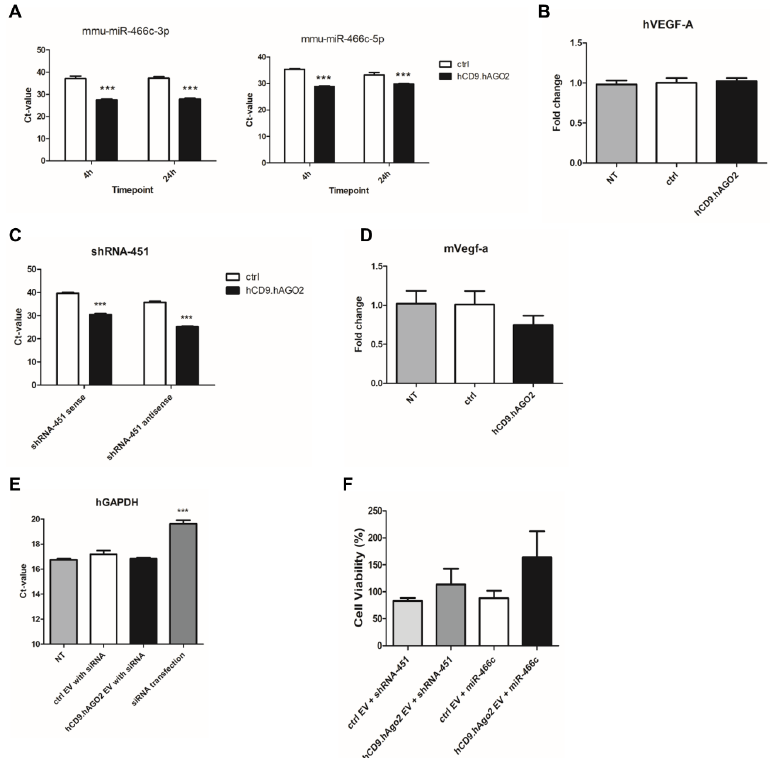
Figure 3. Delivery of RNA to recipient cells using hCD9.hAGO2-engineered EVs. ( A ) hCD9.hAGO2 EVs loaded with miR-466c were shown to deliver the miRNA cargo to recipient ARPE19 cell line more efficiently than control EVs (with endogenous miR-466c loading). The uptake was observed already at 4 h timepoint and also observed still at 24 h timepoint. Data are presented as mean ± SD, n = 4. Two-tailed Student’s t -test: miR-466c-3p 4 h ctrl vs. hCD9.hAGO2 p -value < 0.0001; miR-466c-3p 24 h ctrl vs. hCD9.hAGO2 p -value < 0.0001; miR-466c-5p 4 h ctrl vs. hCD9.hAGO2 p -value < 0.0001; miR-466c-5p 24 h ctrl vs. hCD9.hAGO2 p -value 0.0004; ( B ) No effect on VEGFA expression was observed in ARPE19 cells after EV-mediated delivery of miR-466c. Data are presented as mean ± SD, n = 3; ( C ) Transfer of shRNA-451 from the EVs to recipient C166 cell line was observed by qRT-PCR. The fusion protein-enhanced loading to hCD9.hAGO2 EVs increased the shRNA-451 amount taken up in the cells. Data are presented as mean ± SD, n = 3. Two-tailed Student’s t -test: shRNA-451 sense ctrl vs. hCD9.hAGO2 p -value < 0.0001; shRNA-451 antisense ctrl vs. hCD9.hAGO2 p -value < 0.0001; ( D ) No effect on Vegfa expression was observed in C166 cells after the EV treatments (timepoint 7 d). Data are presented as mean ± SD, n = 3; ( E ) siRNA against GAPDH mRNA was loaded to EVs (hCD9.hAGO2 enhanced loading or endogenous loading as a control). ARPE19 cells were treated with the EVs but no change at GAPDH expression levels was observed. As a positive control, we used normal liposomal transfection reagent to deliver the siRNA and observed clear decrease in GAPDH mRNA levels as expected. Data are presented as mean ± SD, n = 3. Two-tailed Student’s t -test: NT vs. siRNA transfection p -value < 0.0001; ( F ) siRNA against GAPDH mRNA was loaded to EVs (hCD9.hAGO2 enhanced loading or endogenous loading as a control). ARPE19 cells were treated with the EVs but no change at GAPDH expression levels were observed. As a positive control, we used normal liposomal transfection reagent to deliver the siRNA and observed clear decrease in GAPDH mRNA levels as expected. Data are presented as mean ± SD, n = 3. Two-tailed Student’s t -test: NT vs. siRNA transfection p -value <